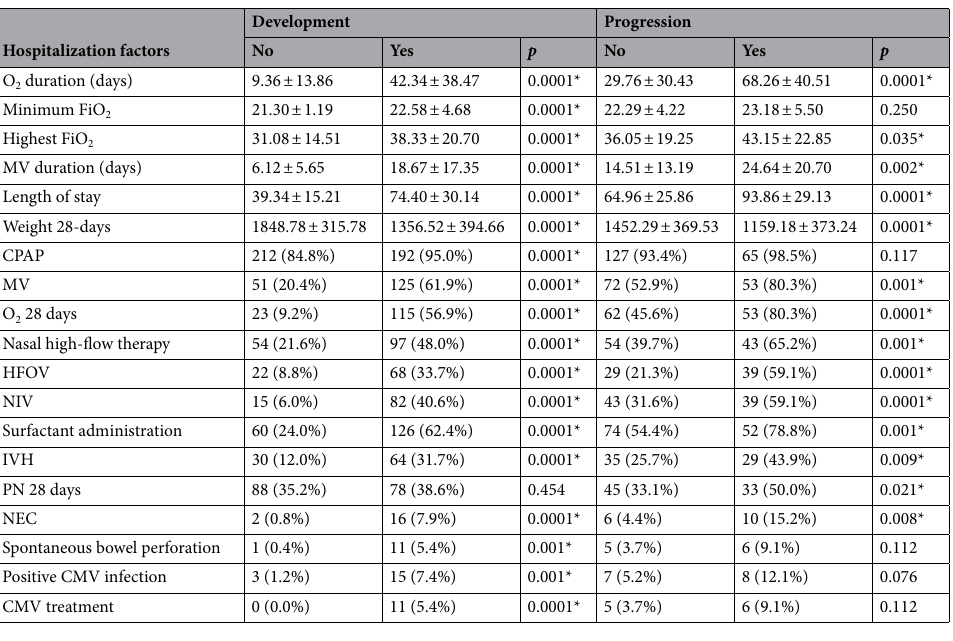
Table 5. Significant hospitalization risk factors after univariate analysis for ROP development and progression. MV mechanical ventilation, CPAP continuous positive airway pressure therapy, HFOV High frequency oscillatory ventilation, NIV non-invasive ventilation, NEC necrotizing enterocolitis, CMV cytomegalovirus. *p < 0.005. Percentages refer to children with the risk factor.